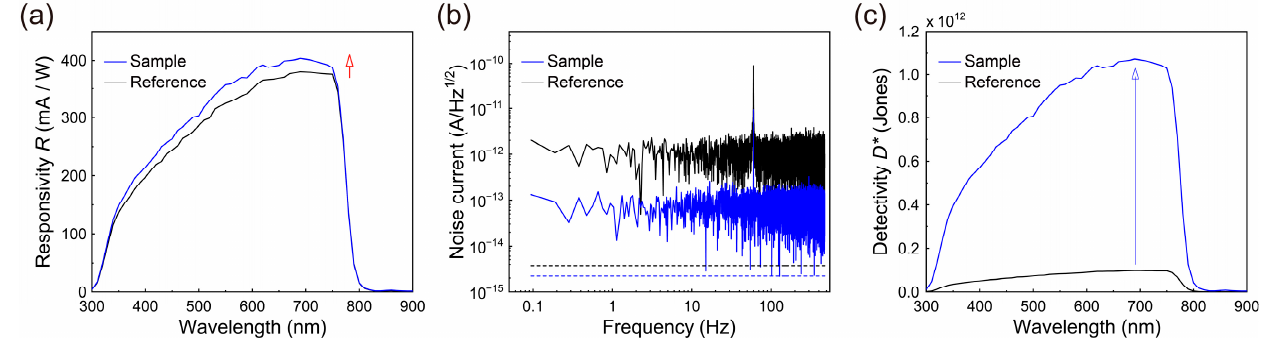
Figure 4. ( a ) Responsivity R λ spectra at zero bias voltage, ( b ) noise currents vs. frequency characteristics, and ( c ) specific detectivity D * spectra at zero bias voltage for the photodiodes of the reference and sample. The dotted lines in ( b ) show the shot noise levels for the reference (black) and sample (blue).